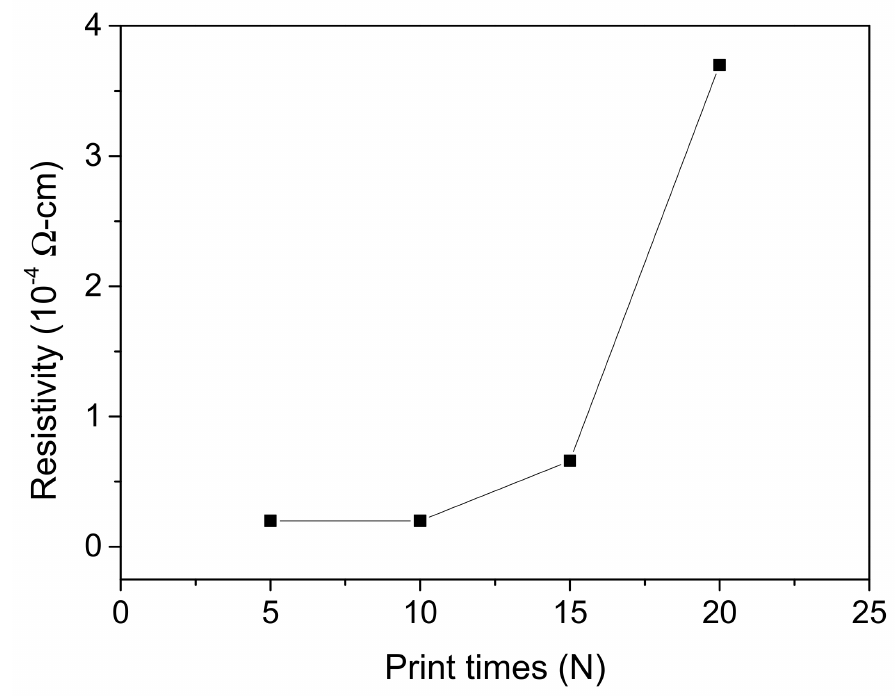
Figure 11. Effect of printing times on electrical